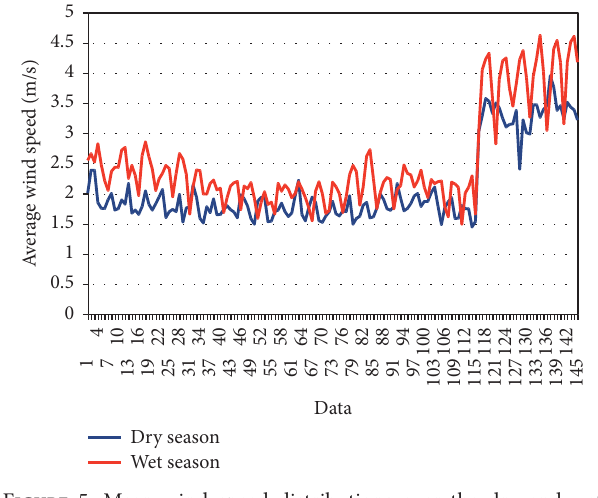
Figure 5: Mean wind speed distributions over the dry and wet seasons.